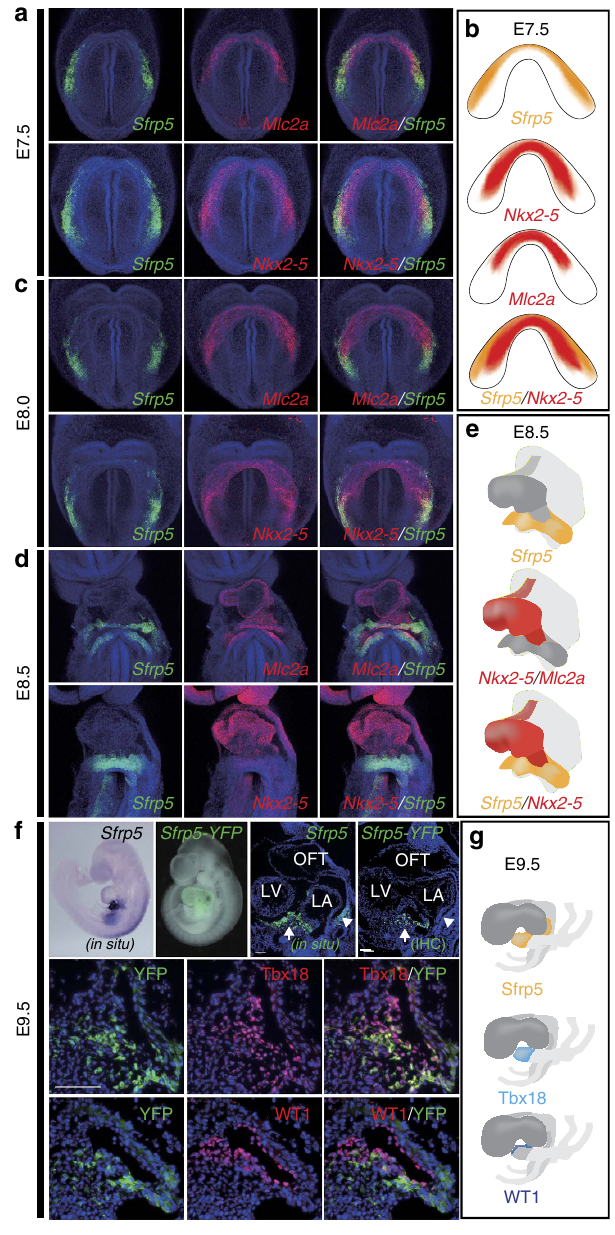
Figure 1 | Sfrp5 is expressed in the lateral cardiac crescent and subsequently in the SV. ( a , c , d ) Double fluorescent whole-mount ISH of mouse embryos at E7.5 ( a ), E8.0 ( c ) and E8.5 ( d ) for detection of Sfrp5 (green) using Mlc2a or Nkx2-5 (red) as indicated in each panel. ( b , e , g ) Schematic drawings of gene expression ( b , e ) and protein distribution ( g ). ( f ) Whole-mount ISH ( in situ ), YFP image merged with bright field image ( Sfrp5-YFP ), section in situ with probe for Sfrp5 and single or double immunohistochemistry (IHC) of Sfrp5-venusYFP KI embryos using anti-GFP antibodies with anti-Tbx18 or anti-WT1 antibodies at E9.5, as indicated in each panel. Scale bars ¼ Scale bars, 50 m